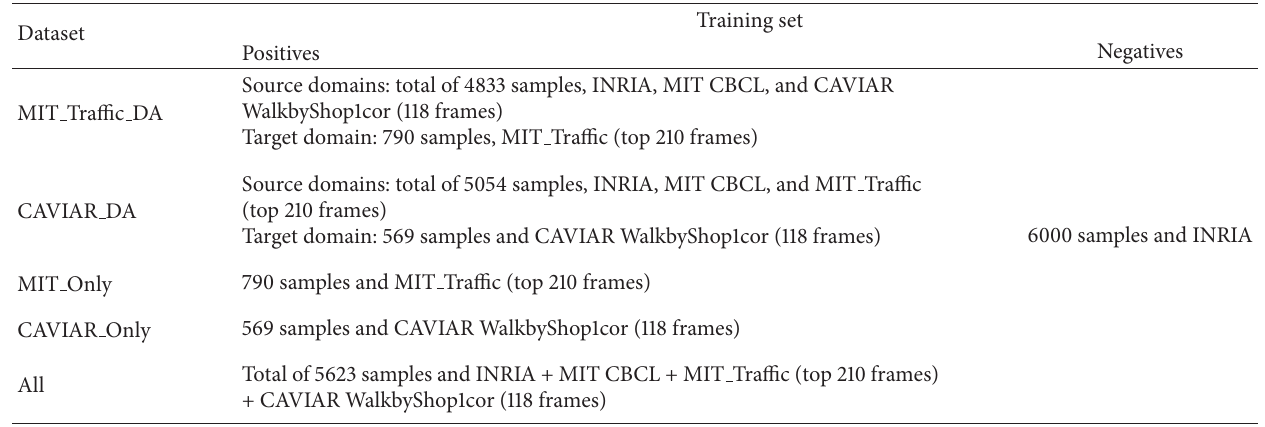
Table 1: The descriptions of the datasets for training.